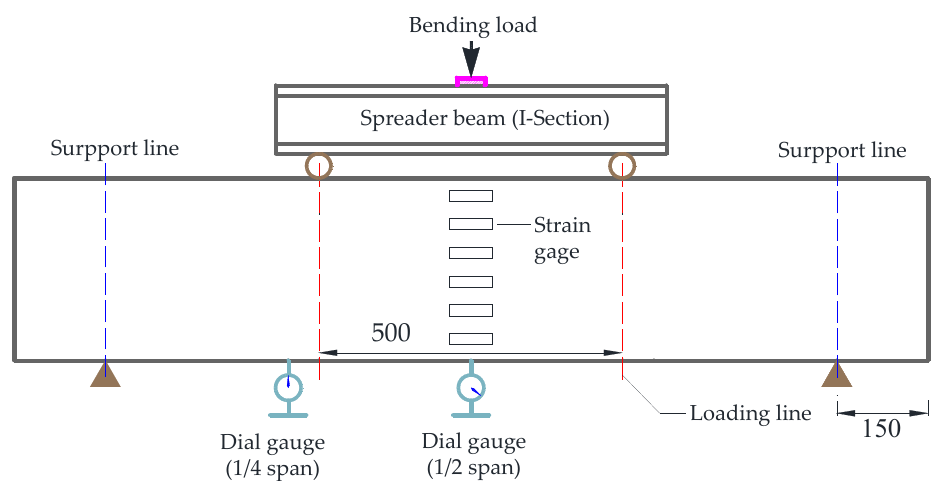
Figure 3. Sketch of the experimental setup for the four-point bending test (unit: mm). As shown in Figure 3, the dial gauges were arranged at the bottom of the 1/2 and 1/4 span of the beams for recording the deflection values during the loading process. Simul- taneously, Six strain gauges were arranged along the beam height of 1/2 span to record the strain change during the test. Additionally, a multi-step loading process (20 kN for each step) was adopted, and the loading rate was controlled to be 0.037 kN/s.